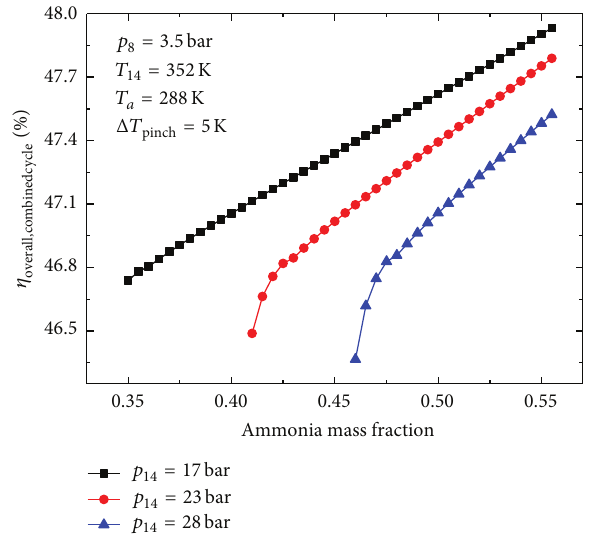
Figure 15: Variation of overall efficiency of combined cycle with ammonia mass fraction.